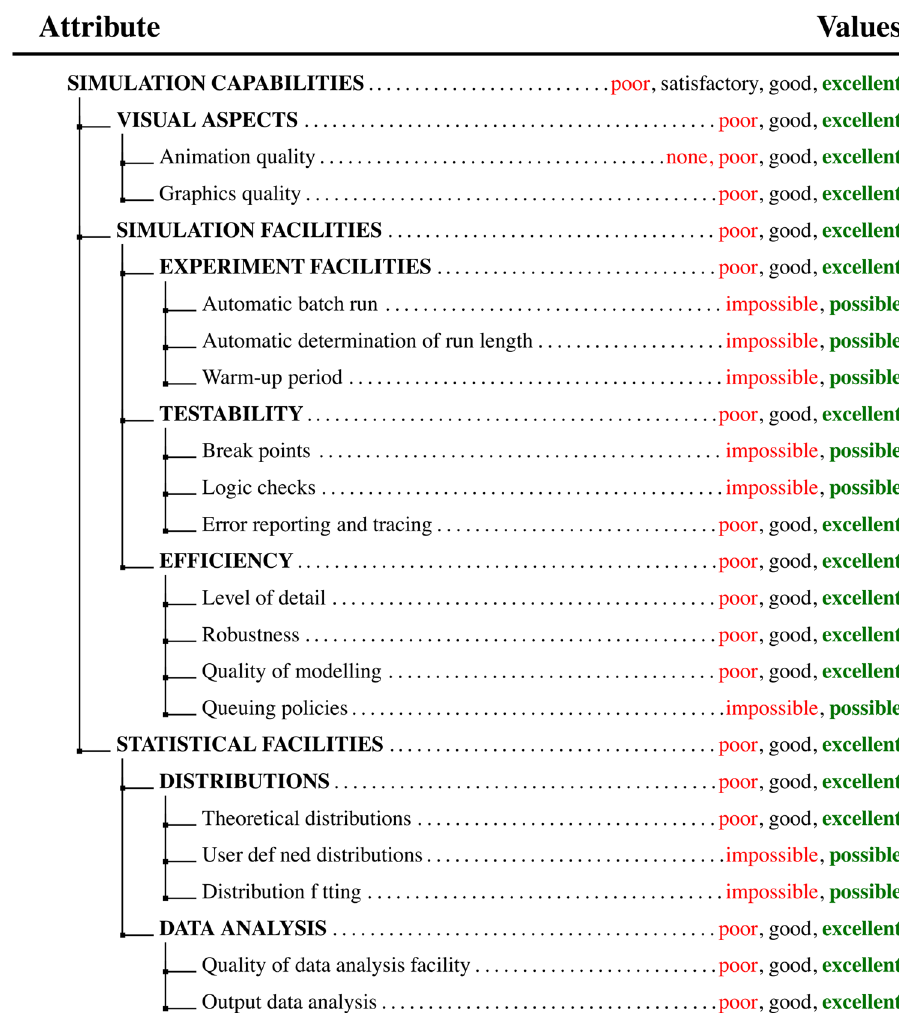
Fig 3. DEX model